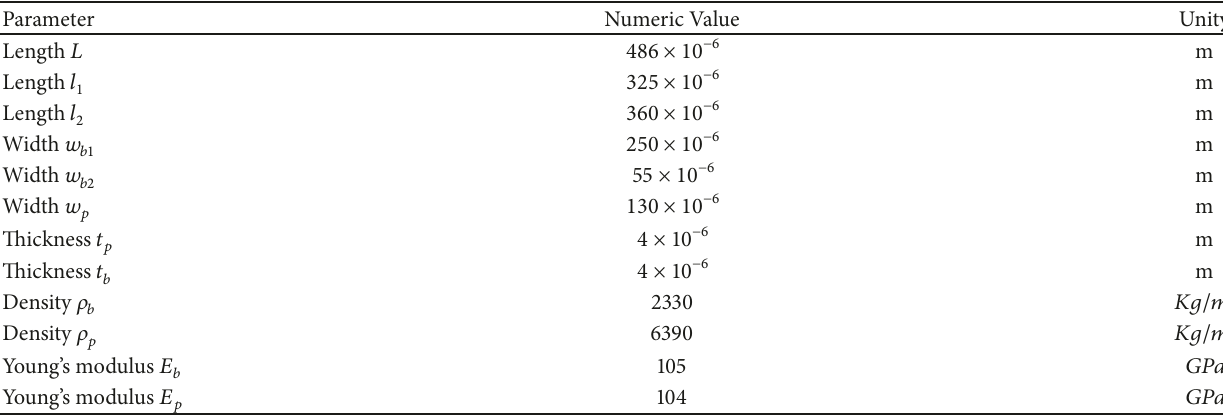
Table 1: Parameters of piezoelectric multispan beam.